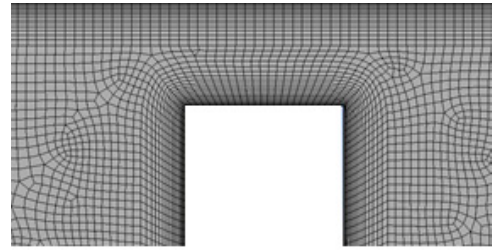
Figure 5. Grid over the top of the tooth in the clearance.